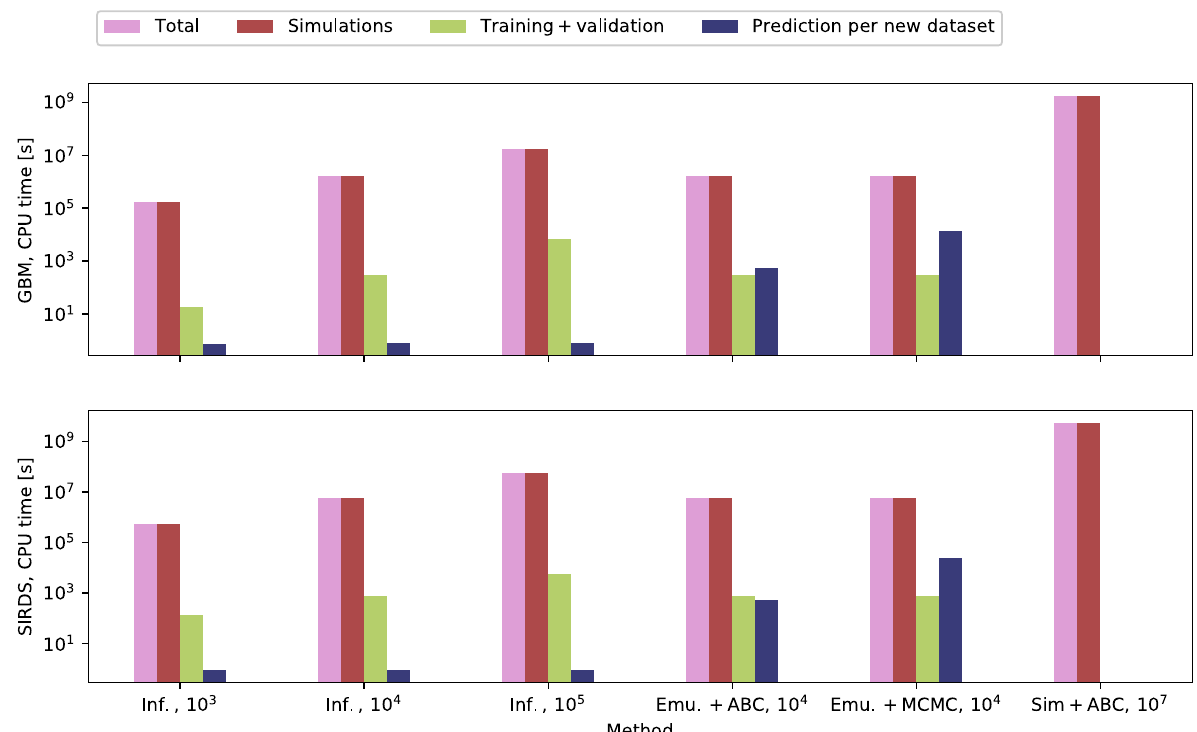
Fig 6. Required CPU time across different methods for our cancer CA model (upper panel) and the epidemiological SIRDS model (lower panel). The light magenta bars show the total time required for each inference technique. The remaining three bars specify the time required for the simulations involved (red), the time required for training and validation (yellow), and the time that is needed to infer the parameters for a single set of observations (blue). The number of required simulations is specified in the labels. We include the NN direct inference machine based on three different sizes of the training set. Moreover, we include the NN emulator in tandem with the rejection ABC and MCMC algorithms. The ABC accepts the best 10 4 among 10 7 randomly drawn samples. The ensemble MCMC uses 8 walkers, drawing 20,000 samples for each walker. For the MCMC, we average over the CPU times for cases a and b. For comparison, we include the estimated time required for running the ABC with 10 7 simulations. Note that the ordinate is logarithmic. Note also that the time needed to run any given simulation depends on the number of agents and the model